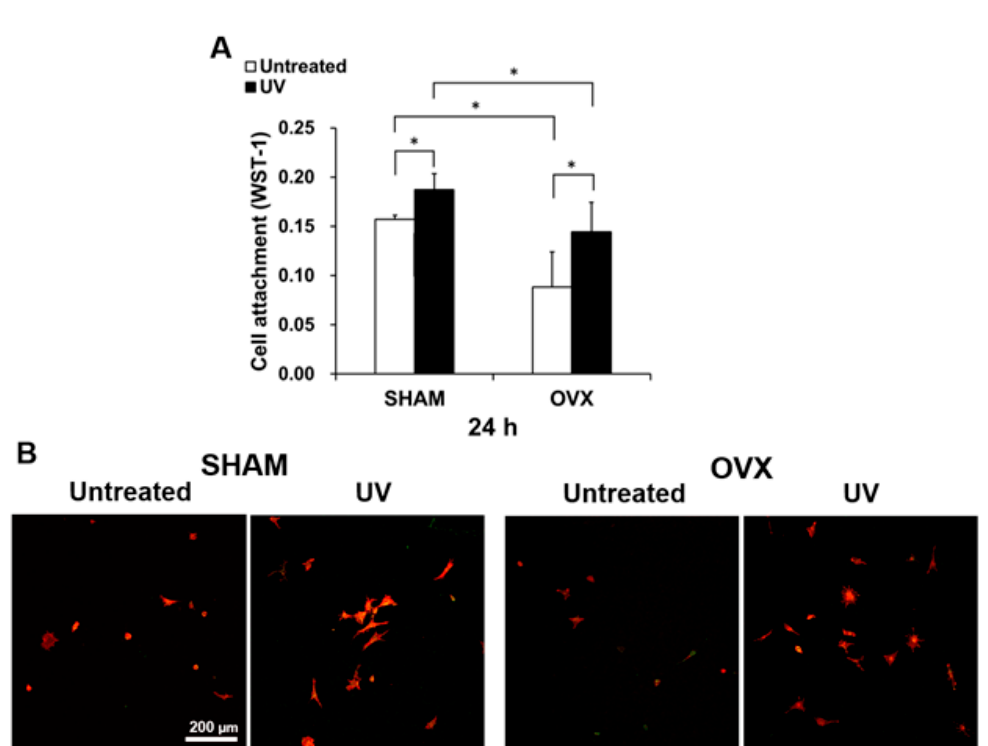
Figure 2. Cell attachment of osteoblasts from sham and OVX groups on acid-etched titanium surfaces with or without UV. ( A ) Number of attached cells after 24 h-incubations evaluated by WST-1 assay. ( B ) Initial spread of osteoblasts at 24 h after seeding on titanium surface. Representative confocal microscopy images of cells stained with rhodamine phalloidin for actin filaments (red) and anti-vinculin for vinculin (green). Each value represents the mean ± standard deviation from triplicate experiments ( n = 3). * p < 0.05, significant between untreated and photofunctionalized surfaces. Scale bar = 200 µm.